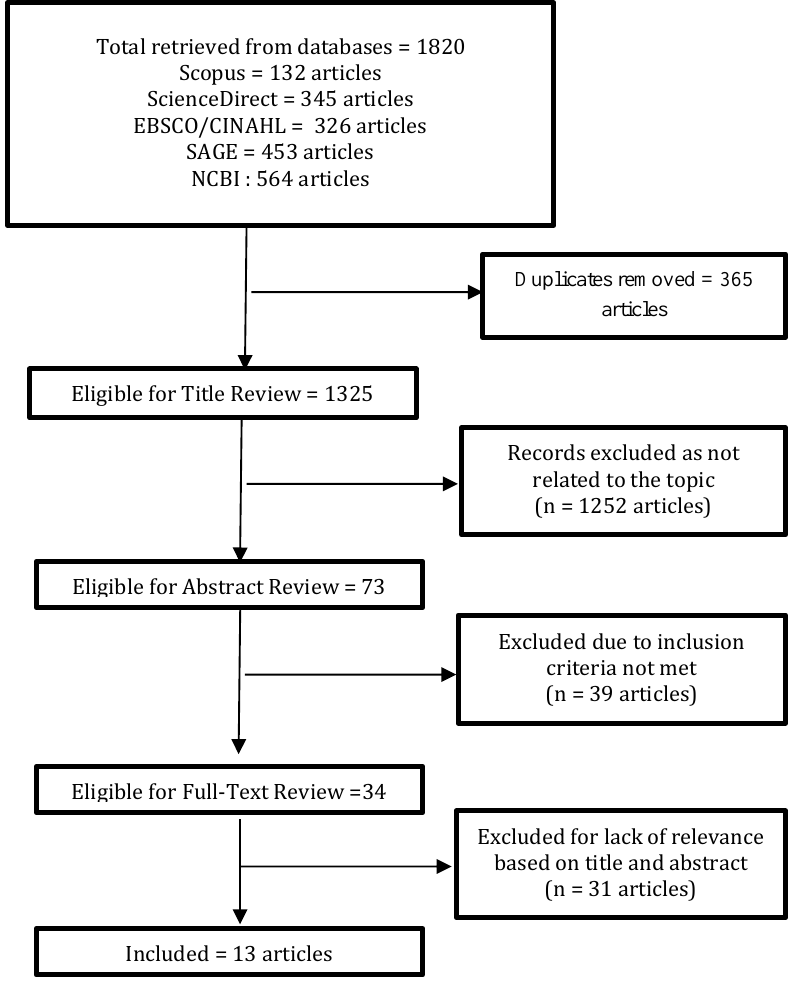
Figure 1. Search